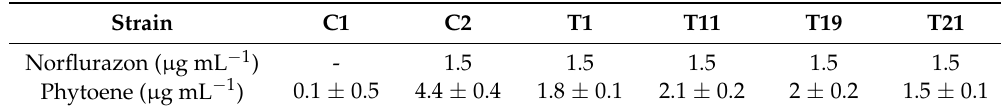
Table 1. Concentration of the colorless carotenoid phytoene in control cells (C2) and Norf R -transformants (T), grown for 24h with norflurazon. Control cells non-treated with norflurazon (C1) have also been included as a reference. Values are the average of three biological replications. Standard deviation is